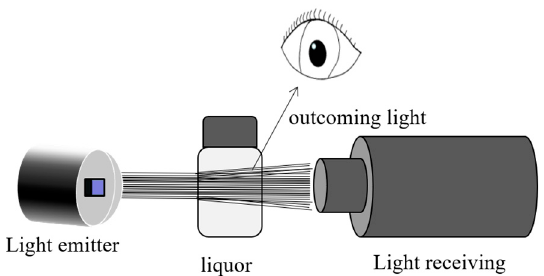
Figure 1. Principle diagram of sauce-flavor liquor identification based on the Tyndall phenome-